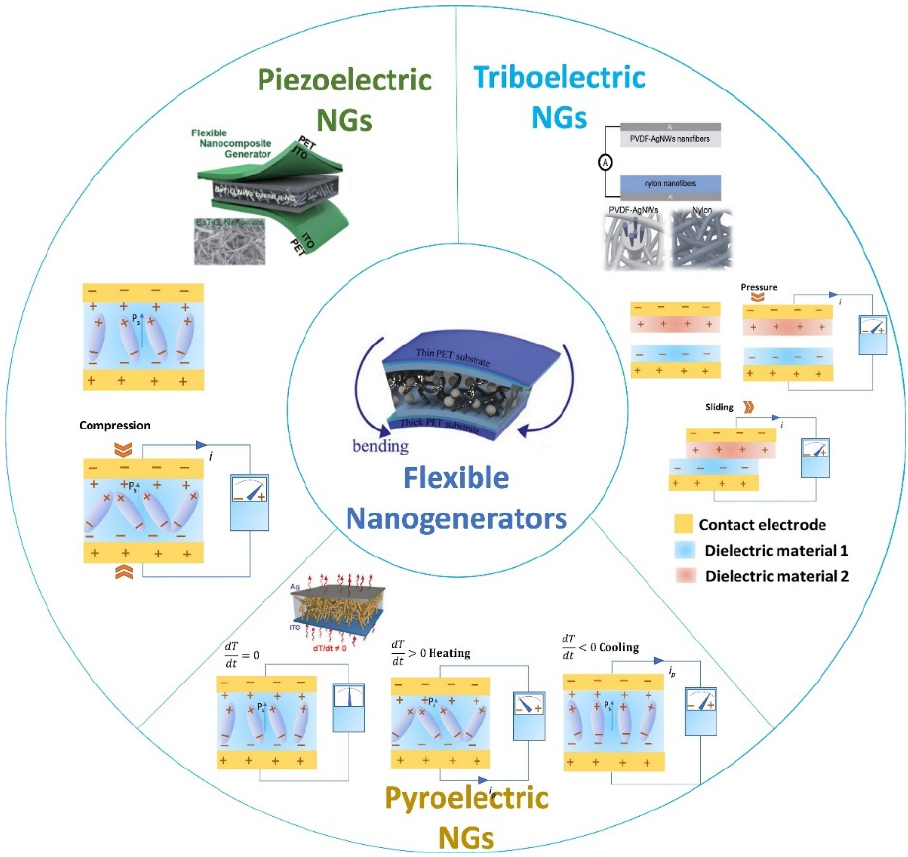
Figure 6. Overview of nanogenerators working principles.